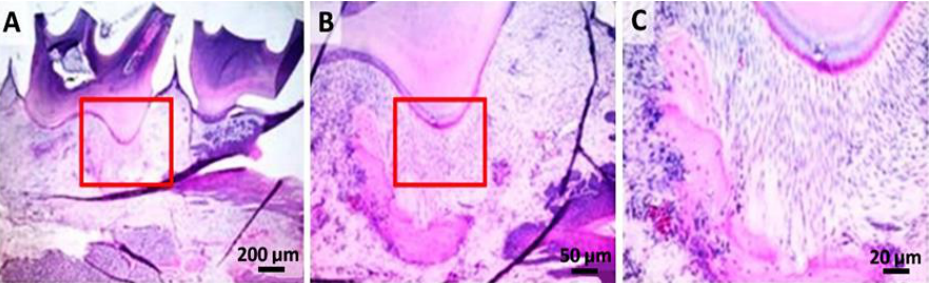
Figure 4. Control group: ( A ) histopathological images from the dental crown and partially from the dental root area (hematoxylin-eosin); ( B , C ) higher resolution, 50µm and 20µm, of the marked zone with red.